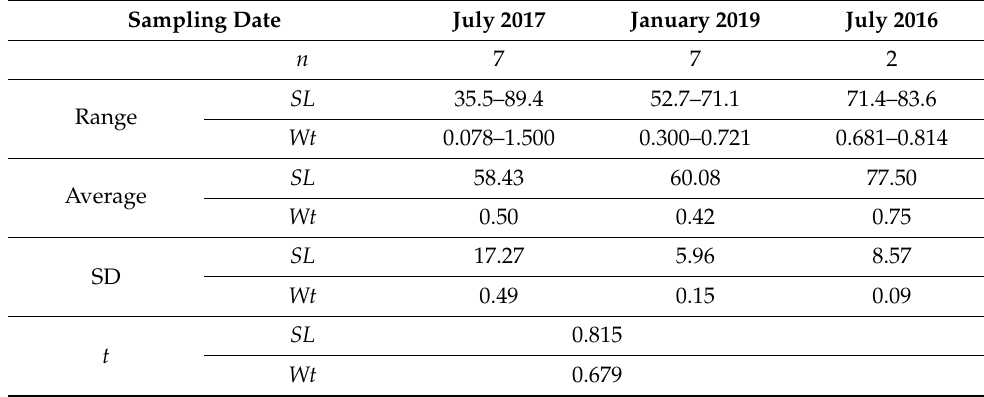
Figure 1. Map of the study area in Geoje-Hansan Bay, Republic of Korea (South Korea). Table 1. Measurements of seahorses at each collection period and the p -value of the t -test.